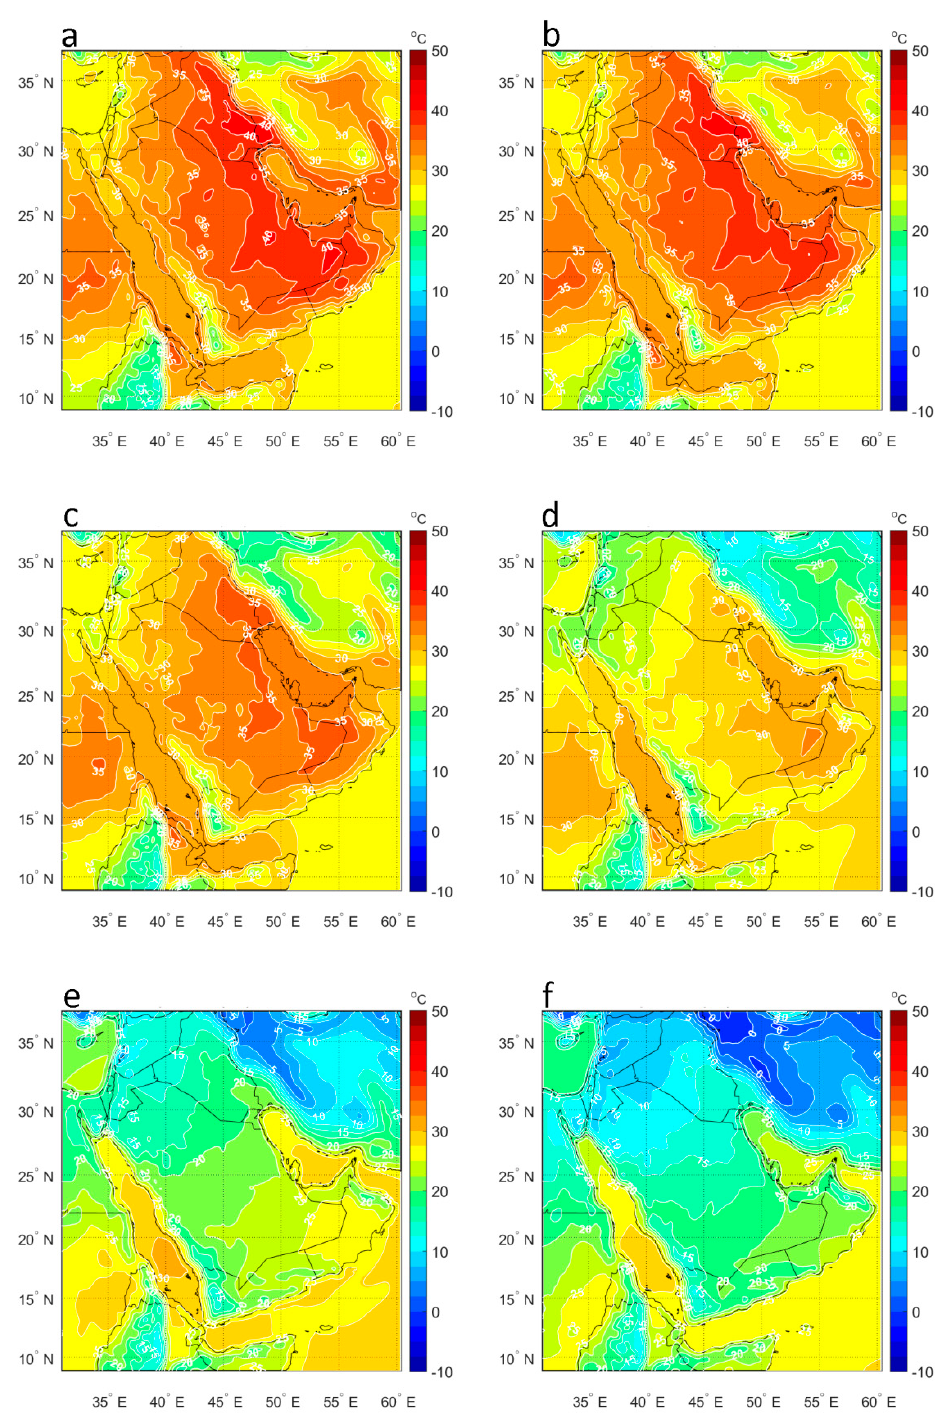
Figure A2. Mean 2 m Temperature for the months July to December ( a – f ).